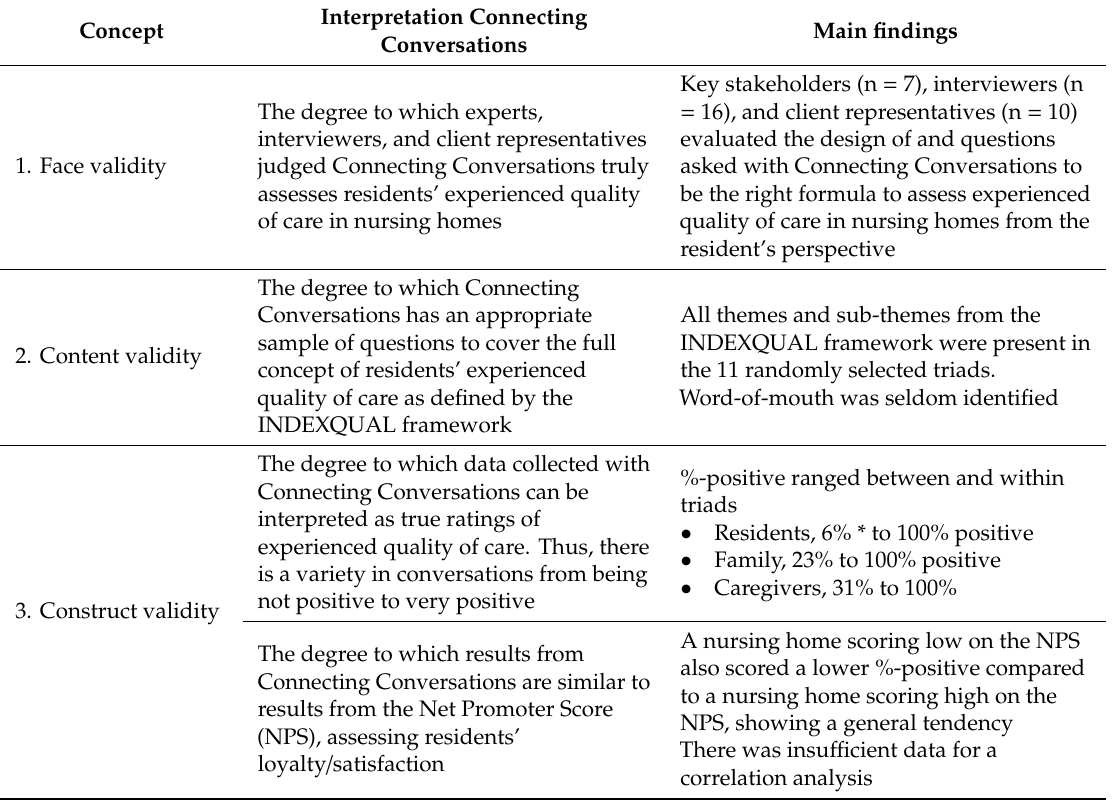
Table 4. Main findings face, content, and construct